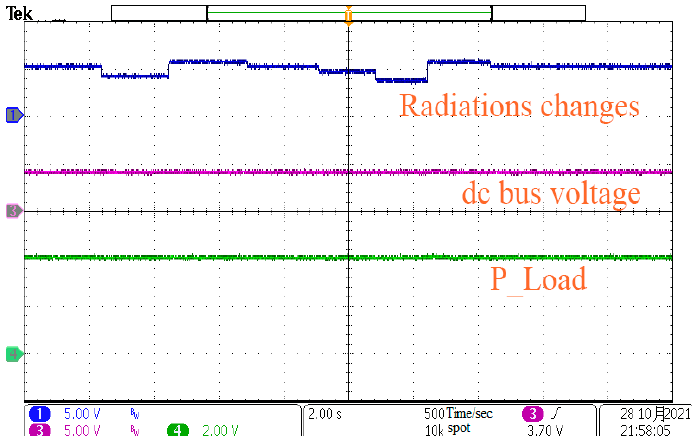
Figure 24. The battery’s current, voltage, and power under load constant and radiation changes.